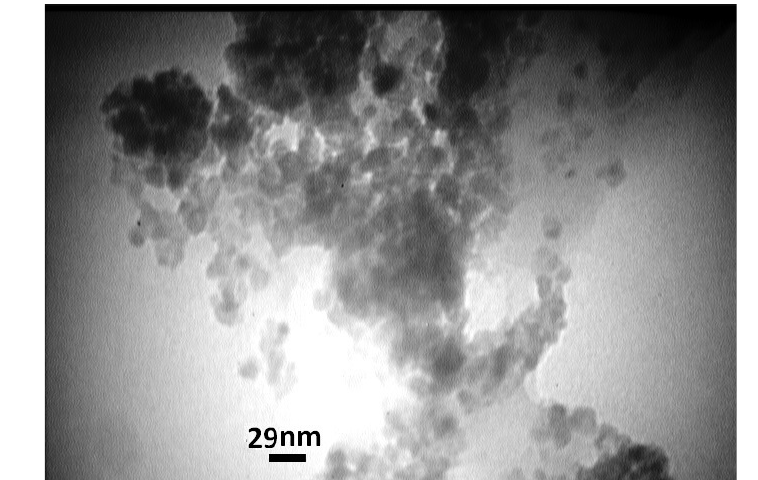
Fig.12 TEM image of the Ag NPs/TiO 2 /SiO 2 sample Fig. 12. TEM image of the Ag NPs/TiO 2 /SiO 2